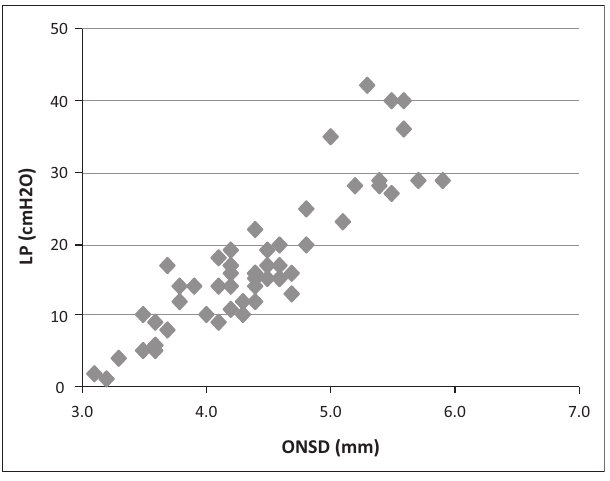
FIGURE 2: Correlation between lumbar puncture opening pressure (cmH optic nerve sheath diameter (mm).